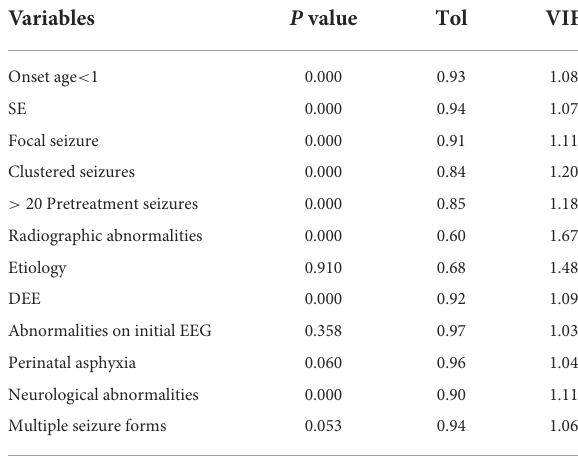
TABLE 3 Variance inflation factor (VIF) and tolerance analysis of